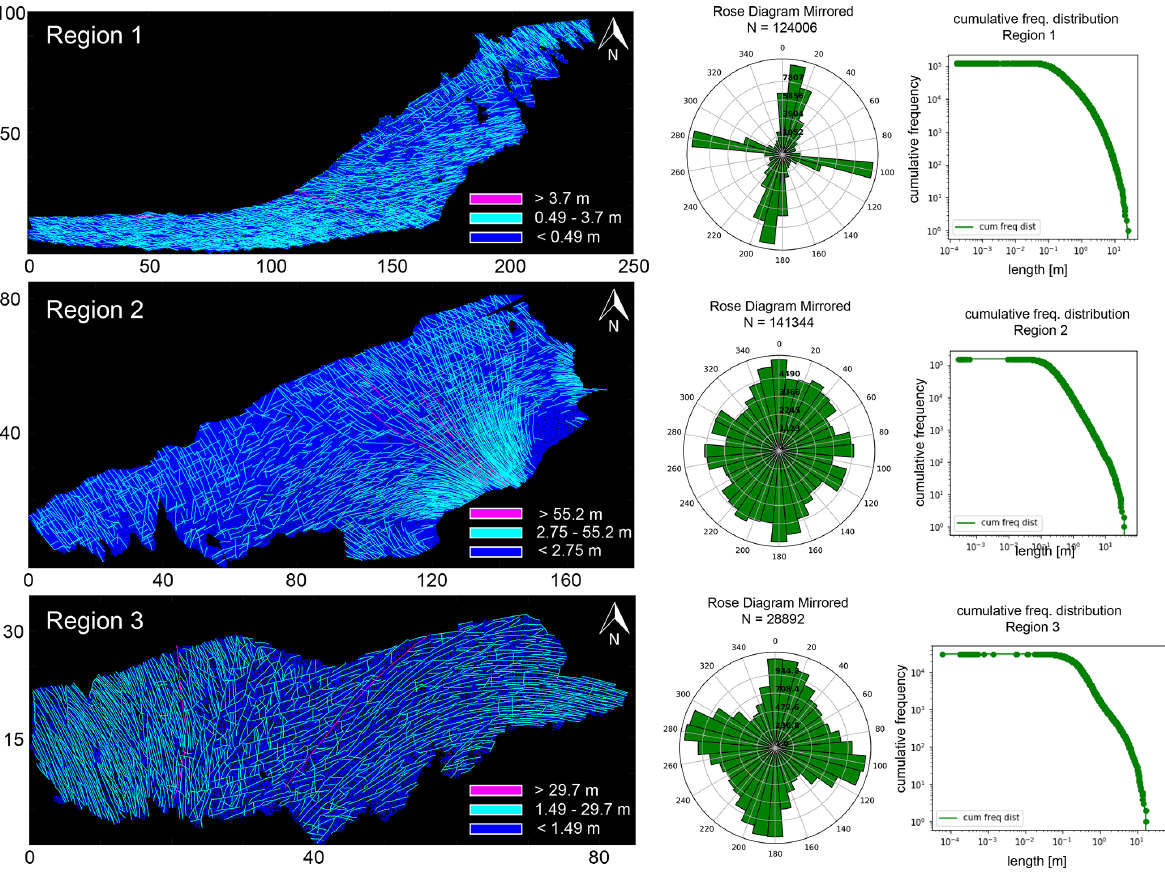
Figure 5. Comparison of the three regions in terms of networks, orientations, and length distributions. Map dimensions are in metres. This image has been modified from Prabhakaran et al. (2021b) with permission.